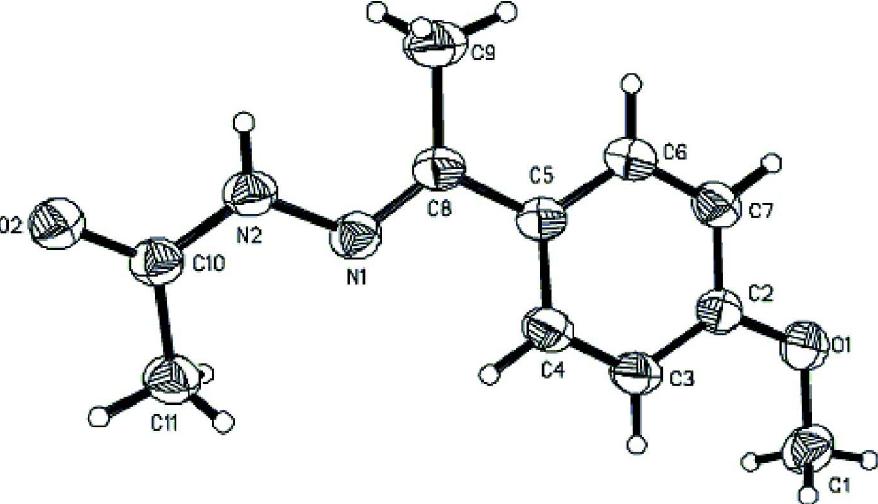
The structure of the title compound showing 30% probability displacement ellipsoids and the atom-numbering